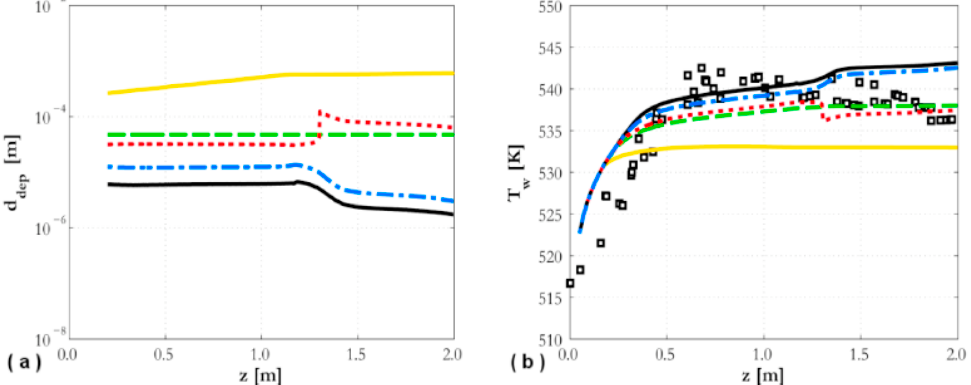
Figure 8. Predicted bubble departure diameter ( a ) and wall temperature ( b ) in typical vertical subcooled flow boiling conditions, from Colombo et al. [27]. Lines correspond to different methods to compute bubble departure diameters: Tolubinskiy et al. correlation [23] (yellow lines), Kocamustafaogullari et al. correlation [21] (green lines), Klausner et al. model [25] (red lines), Sugrue et al. model [28] (black lines), Yun et al. model [34] (blue lines). In panel ( b ), squares denote experimental wall temperature values [22].